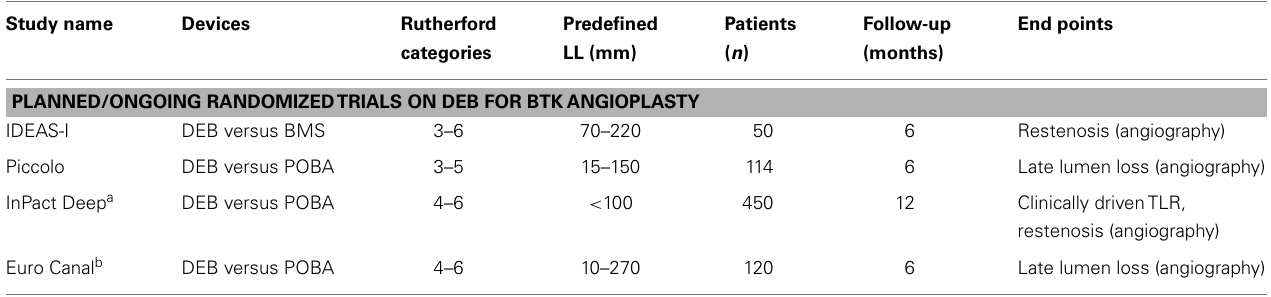
Table 4 | Overview of ongoing/not completed randomized trials on DEB versus BMS or POBA for BTK angioplasty